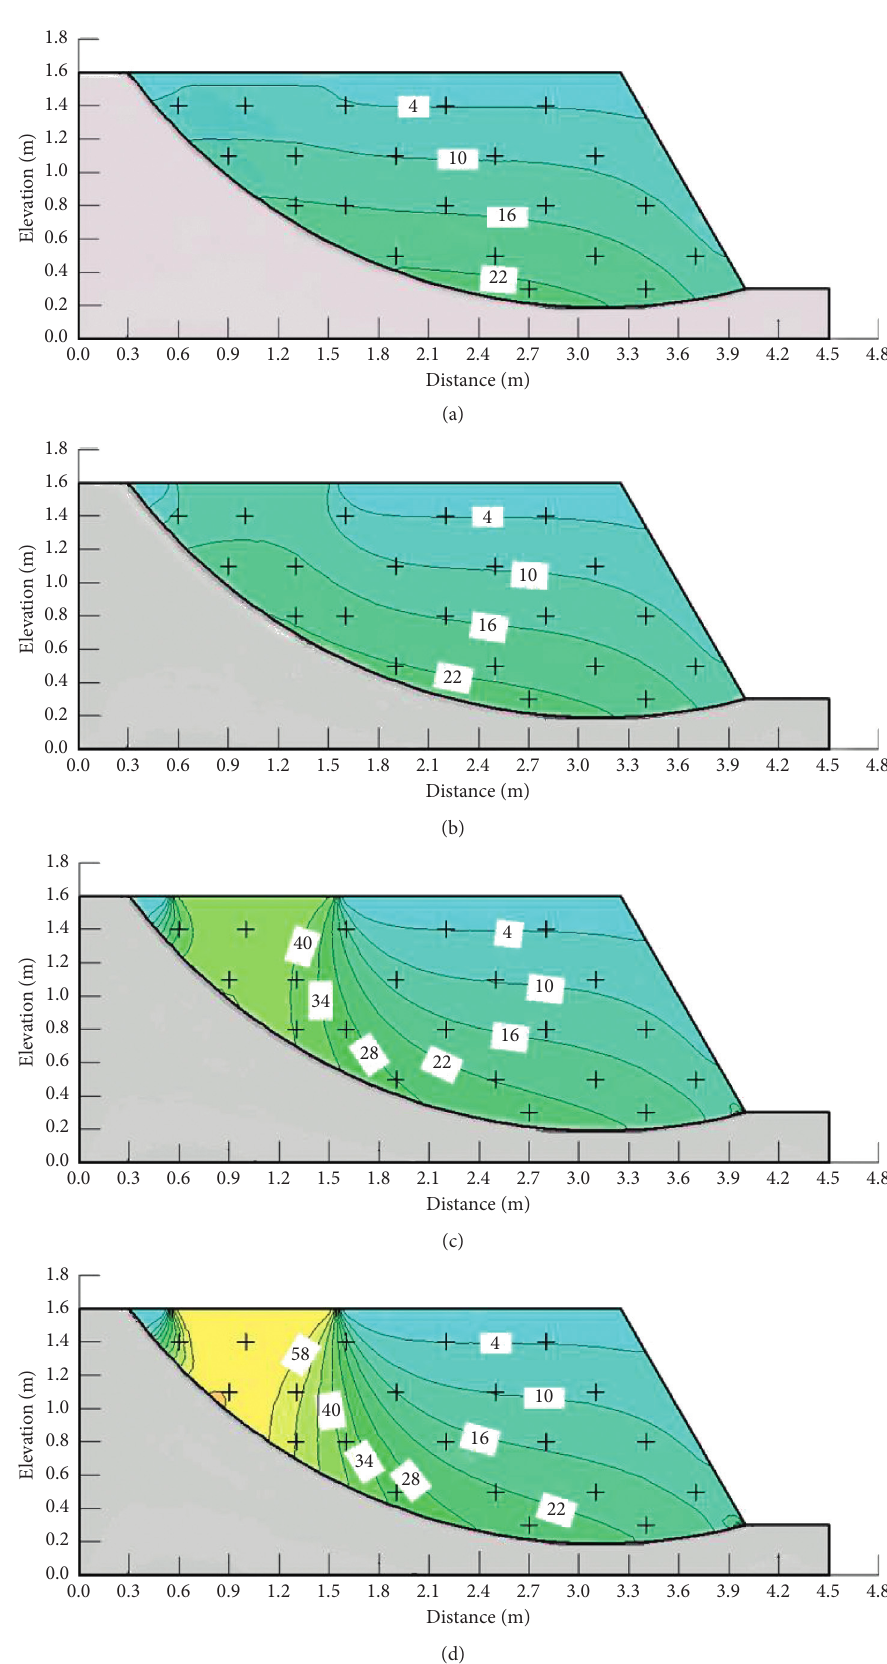
Figure 11: Typical vertical stress contours during loading process (unit of isoline label: kPa). Loading to (a) 5kN, (b) 20kN, (c) 80kN, and (d)